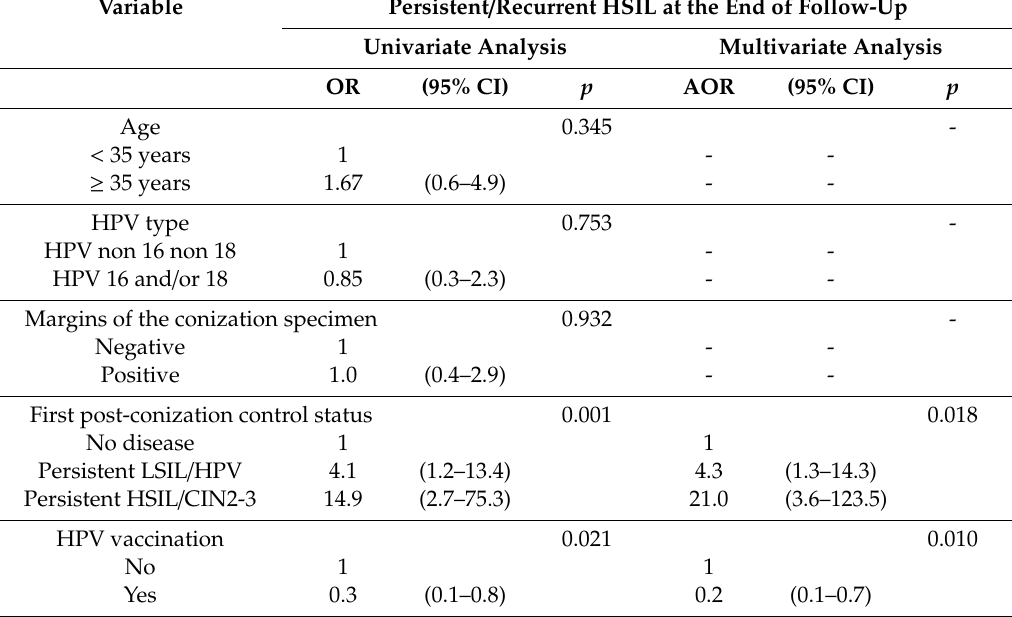
HSIL / CIN2-3: high-grade squamous intraepithelial lesion / cervical intraepithelial neoplasia grade 2-3; OR: odds ratio; AOR: Adjusted OR; CI: confidence interval; HPV: human papillomavirus; LSIL: low-grade squamous intraepithelial lesion. Persistent / recurrent HSIL / CIN2-3 at the end of follow-up is defined as histologically confirmed HSIL / CIN2-3, or a repeated HSIL result in at least two Pap smears separated by six months and positive HPV testing result, independently of the histological